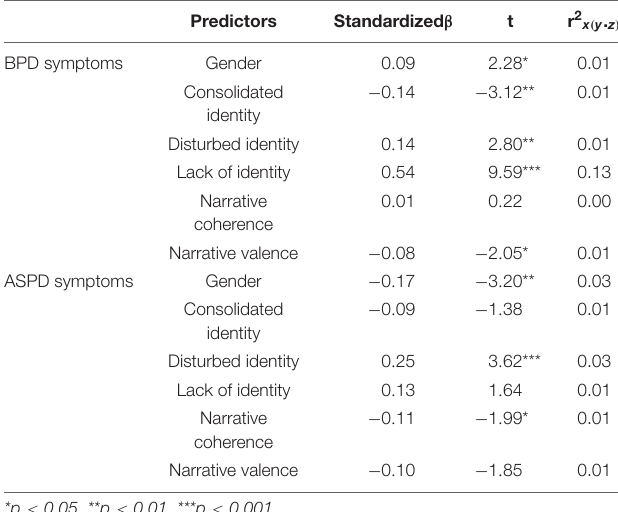
TABLE 3 | Hierarchical linear regression analysis predicting BPD and ASPD symptoms as a function of gender, identity functioning, and narrative coherence.